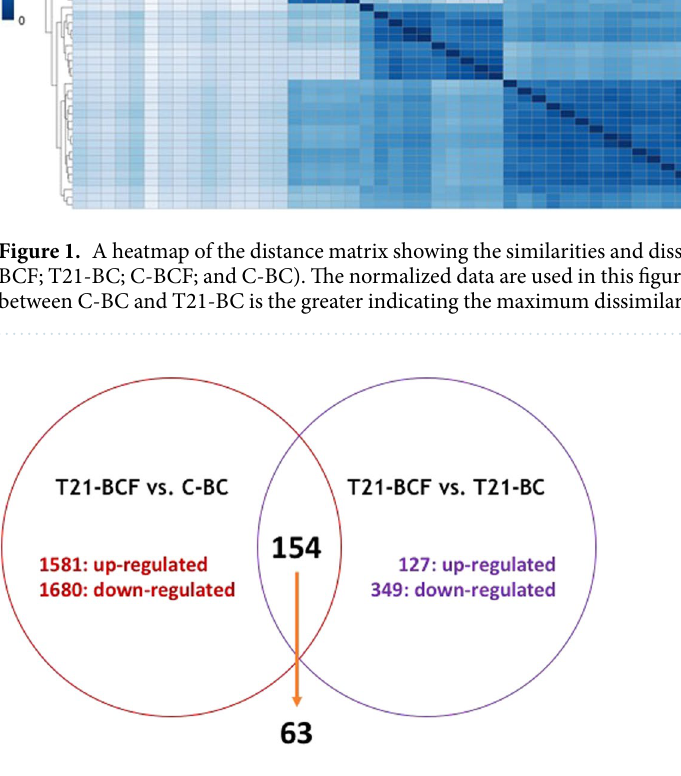
Figure 2. Differential analysis of gene expression between T21-BCF versus C-BC (group ( A ) and between T21-BCF versus T21-BC (group B) showing the number of genes that were differentially expressed. At the intersection of the 2 groups, 154 genes were differentially expressed, of which 63 genes had a similar expression profile (15 up- and 48